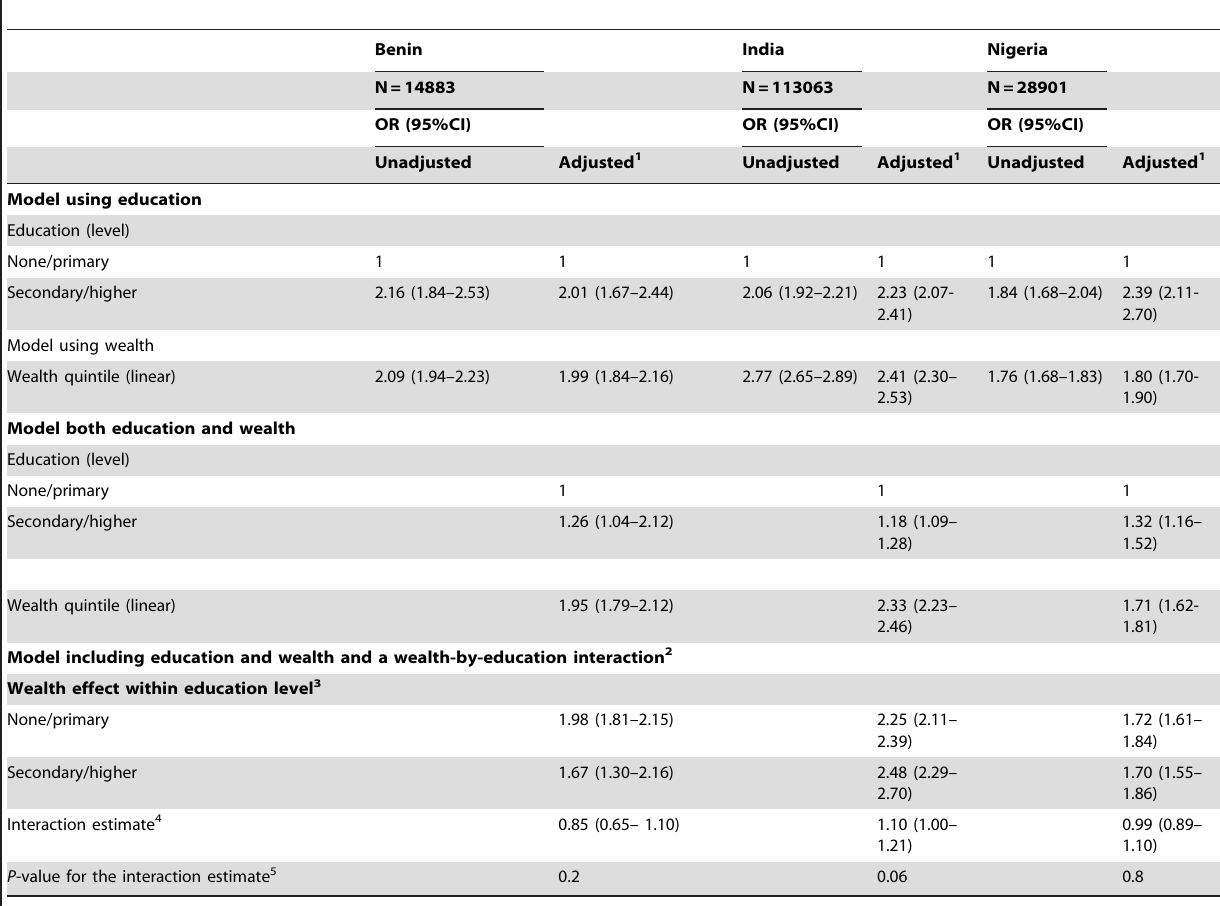
Table 4. Separate, independent and interaction effects of education and wealth on obesity in the low-income countries, DHS